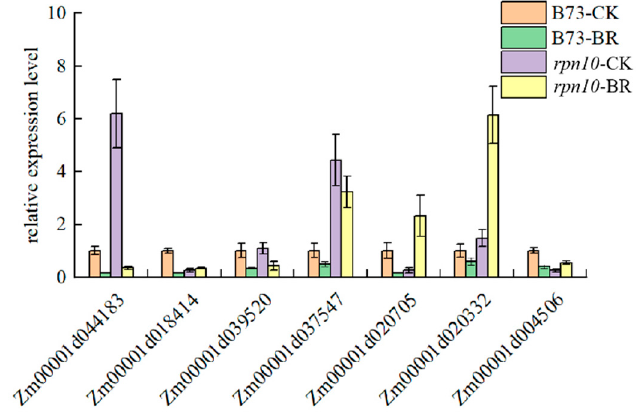
Figure 9. The validation of relative expression of selected genes by qRT-PCR.